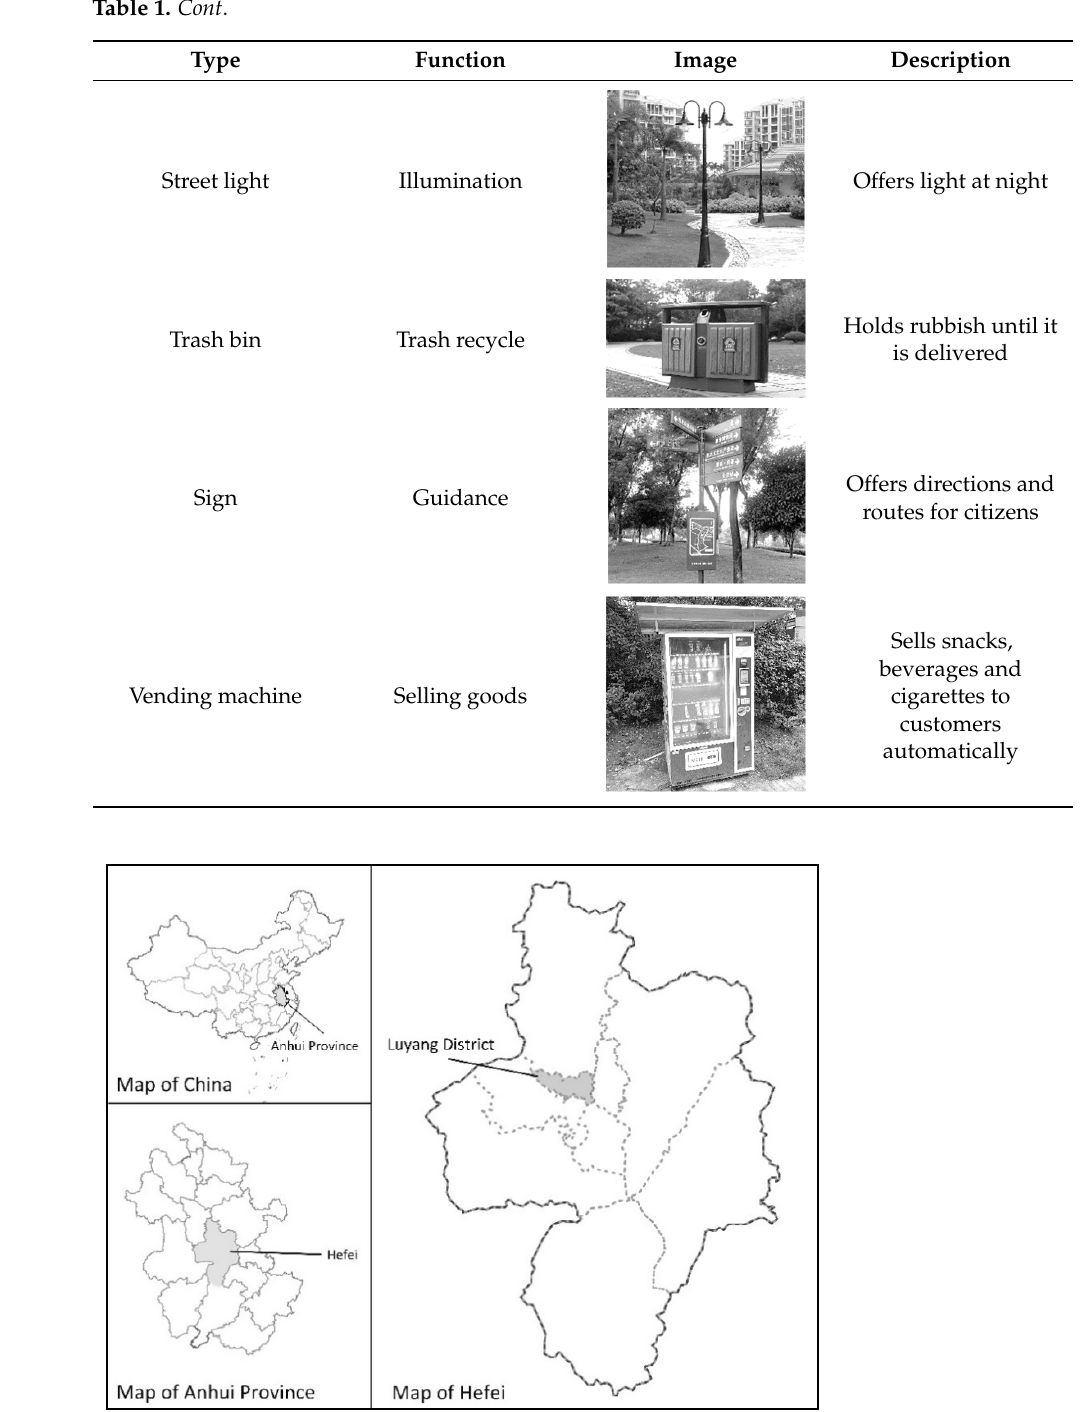
Figure 4. The position of Luyang District.